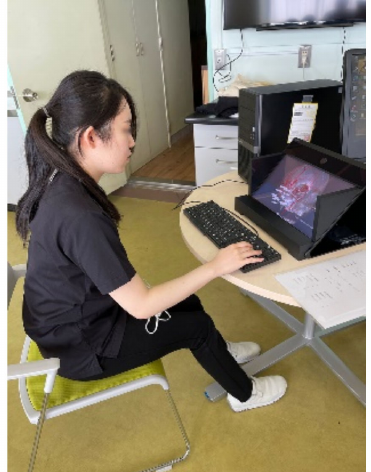
Figure 8. An example of a dental student experiencing the